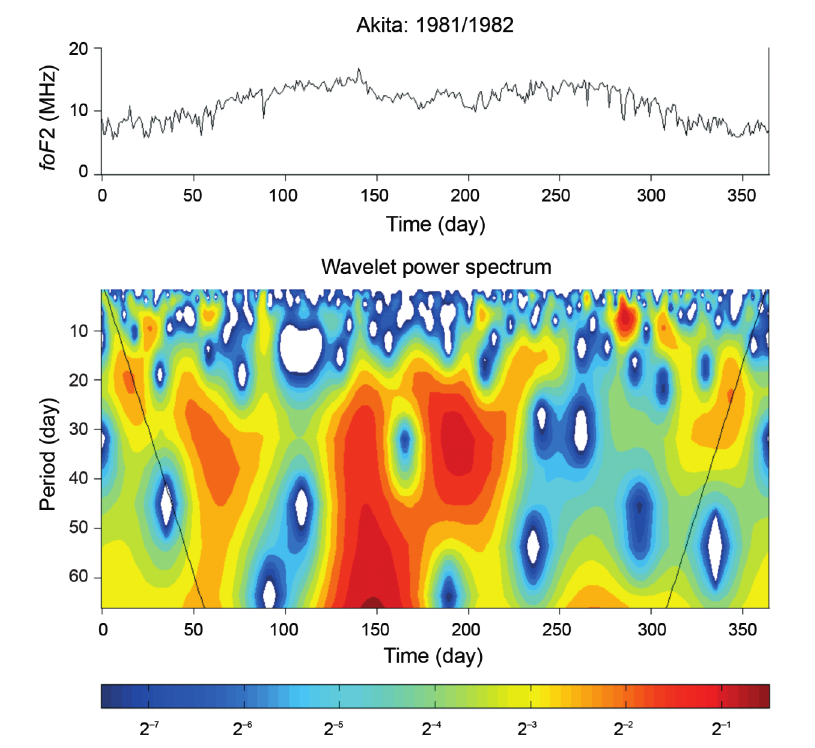
Fig. 2. The same as fig. 1 but for Paul